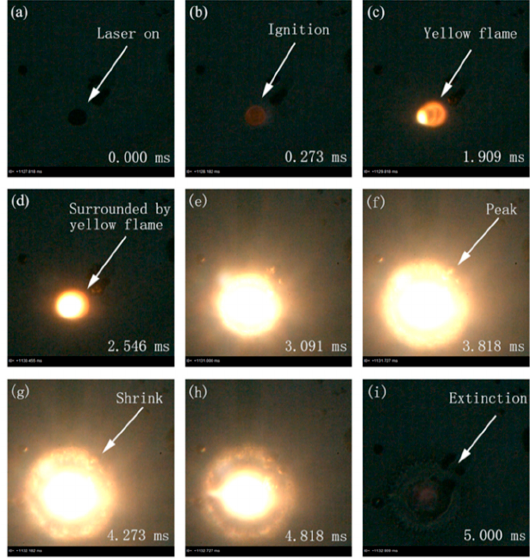
Figure10. Representativesnapshotsoflaser-inducedignitionandcombustionprocessesofanindividual Figure 10. Representative snapshots of laser ‐ induced ignition and combustion processes of an aluminum particle. The diameter was 10.4 µ m. The laser power density was 9.49 × 10 5 W / cm 2 . (Images individual aluminum particle. The diameter was 10.4 μ m. The laser power density was 9.49 × 10 5 W/cm 2 . (Images acquired from Supplementary Materials, Video S2; recording frame: 11,000 fps; acquired from Supplementary Materials, Video S2; recording frame: 11,000 fps; exposure time: 90.9 µ exposure time: 90.9 μ s).